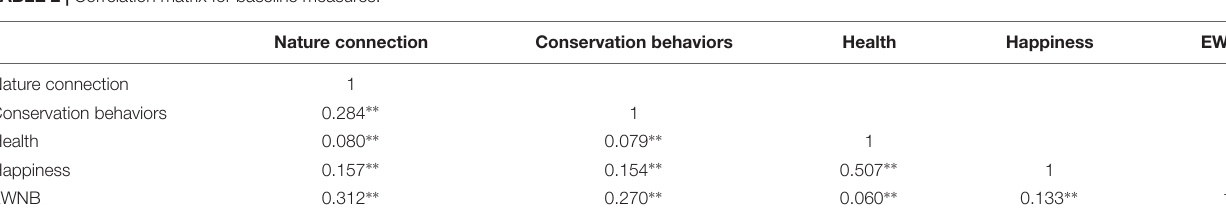
TABLE 2 | Correlation matrix for baseline measures.